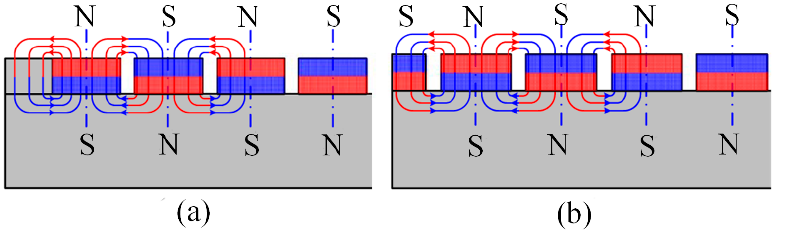
Figure 2. Minimization of the secondary end effect. ( a ) Adding an iron block; ( b ) adding a mirror permanent magnet (PM). Reprinted with permission from ref. [41]. Copyright 2018 IEEE.